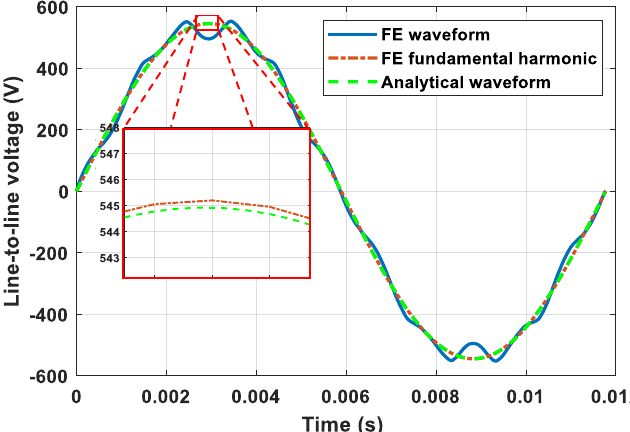
Figure 5. FE no-load line-to-line voltage (in blue) and its fundamental harmonic (in red) vs. analytical no-load line-to-line voltage (in green).